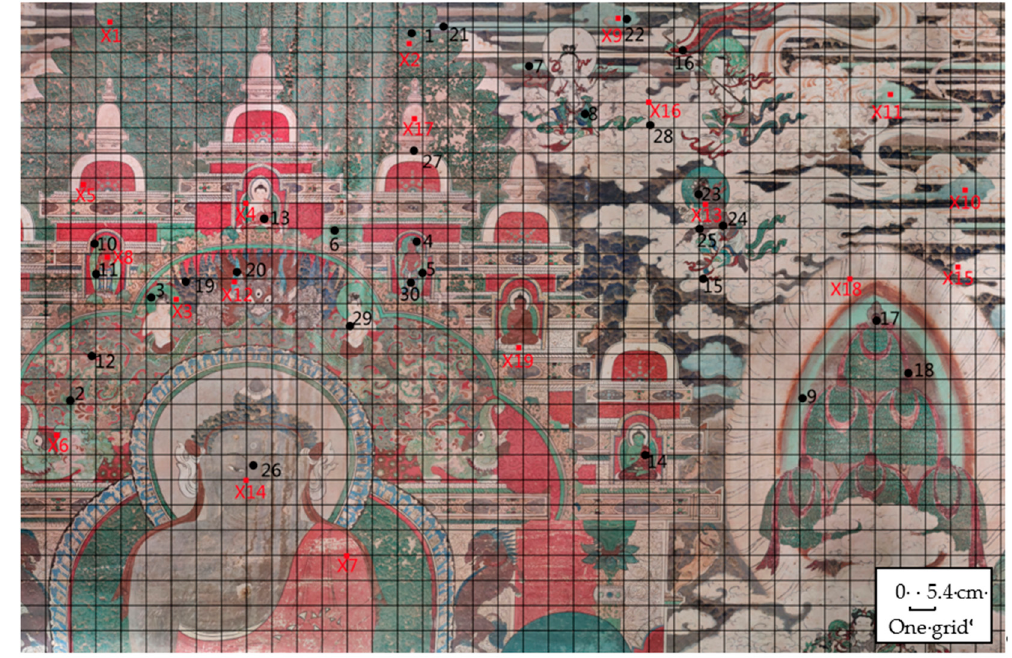
Figure 7. The grid and sample points on surface of the fresco.